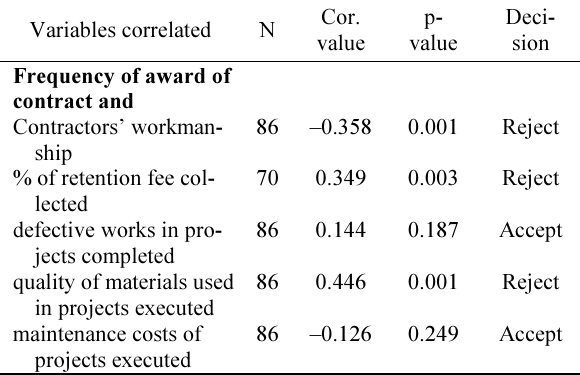
Table 4. Results of Spearman test for correlation between cli- ents’ assessment of the quality performance of con- tractors and the frequency of award to contractors Variables